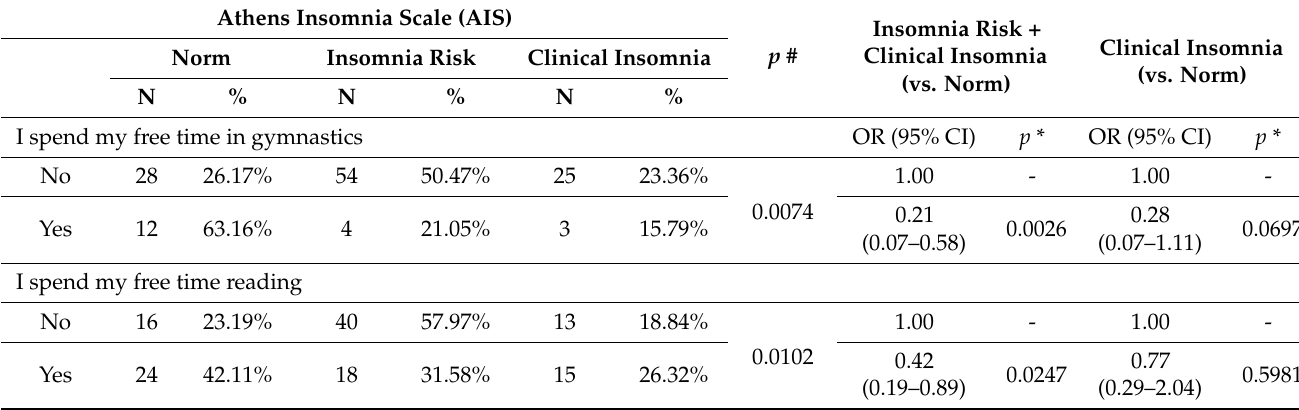
Table 8. The relationship between the way of spending free time and the risk of sleep disorders in the surveyed